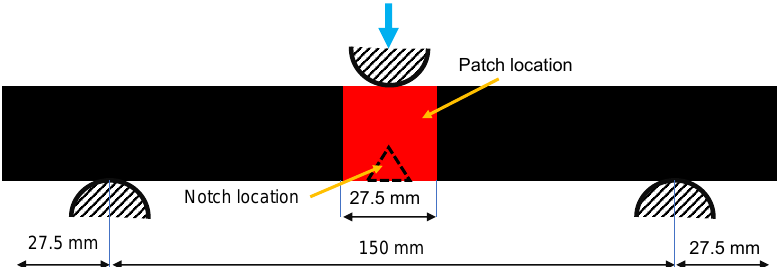
Figure 7. Three-point bending test setup.